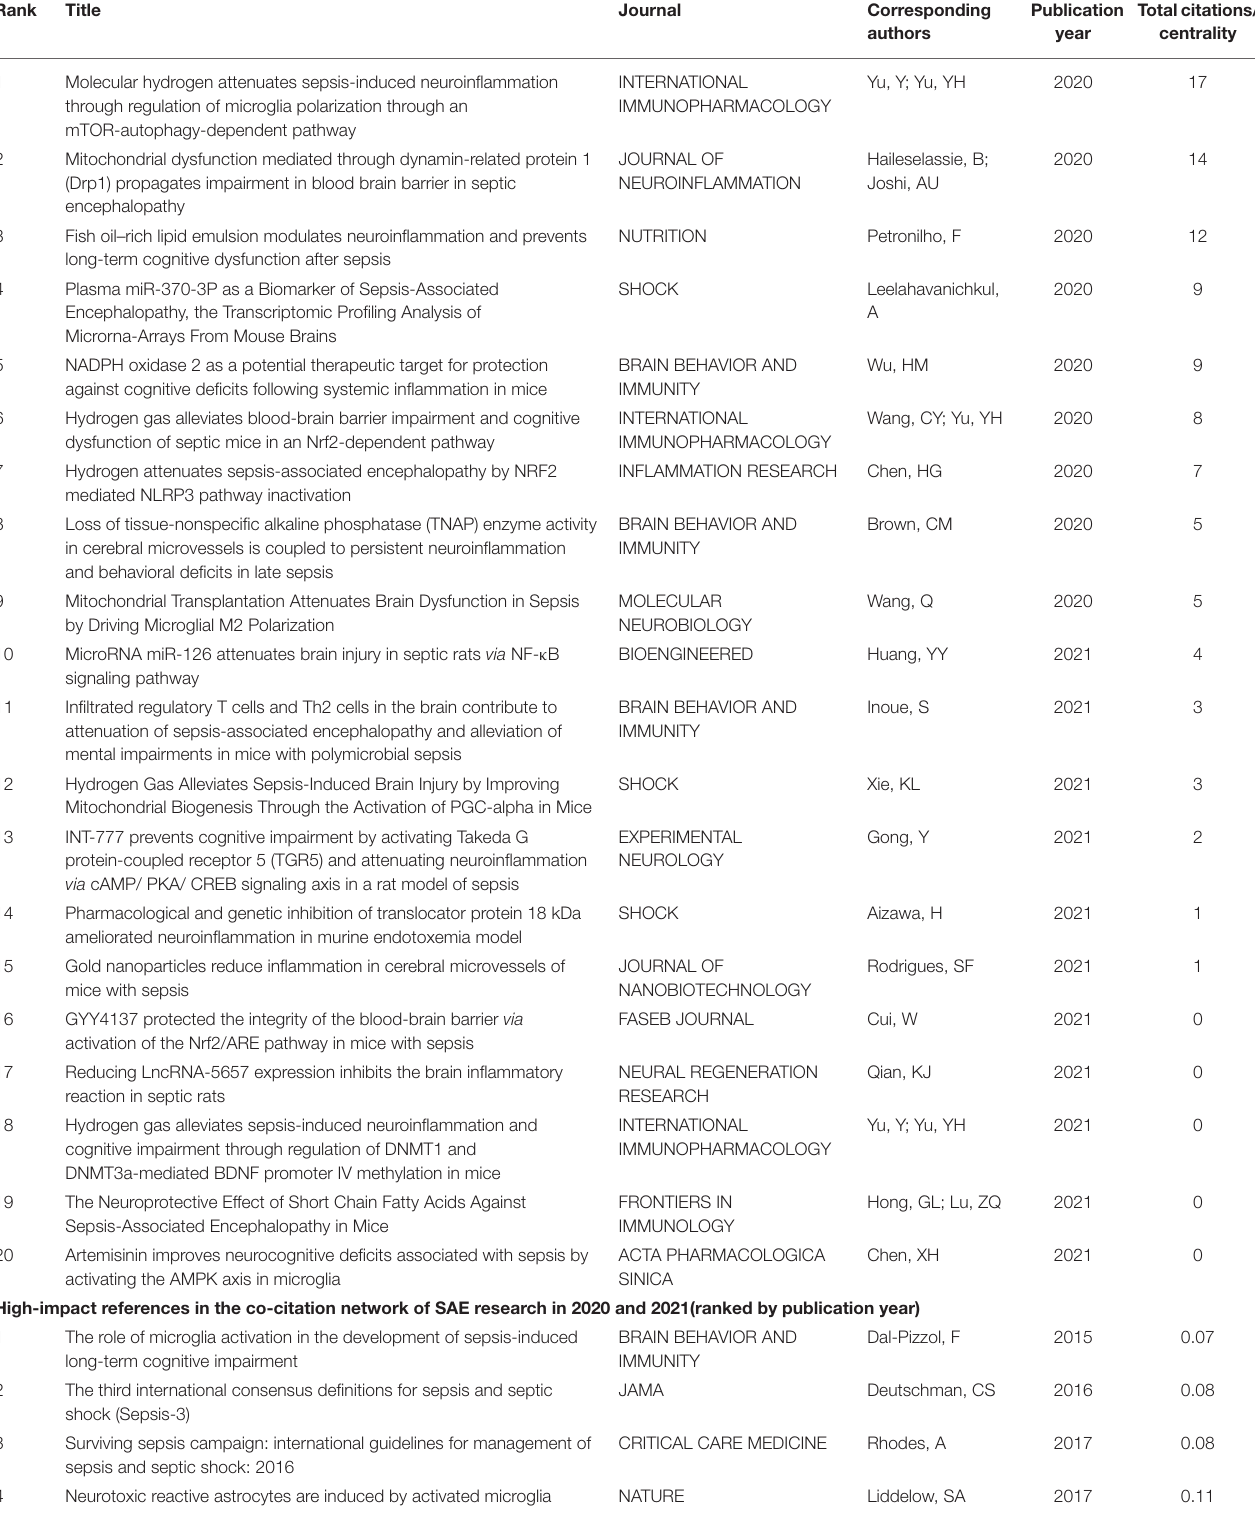
TABLE 3 | Top cited original articles in 2020 and 2021 (ranked by citation